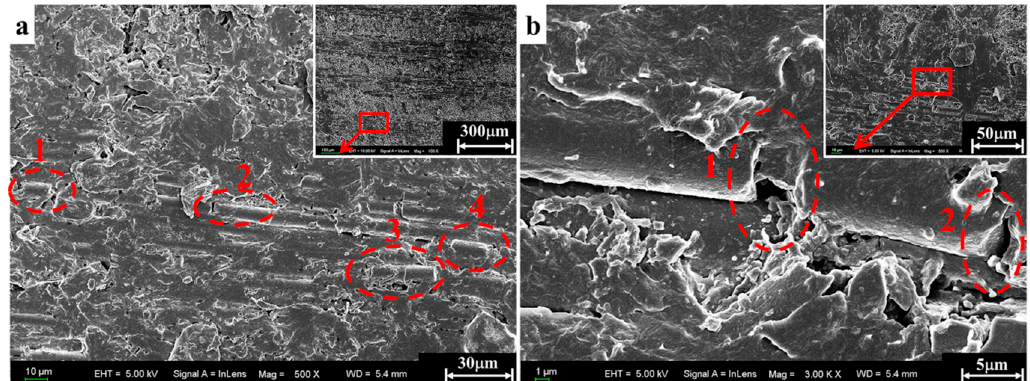
Figure 9. Partial fiber breakage damage observed at different positions of specimen A5 after the test (1489/s). ( a ) The first position with a magnification of 500. ( b ) The second position with a magnification of 3000.